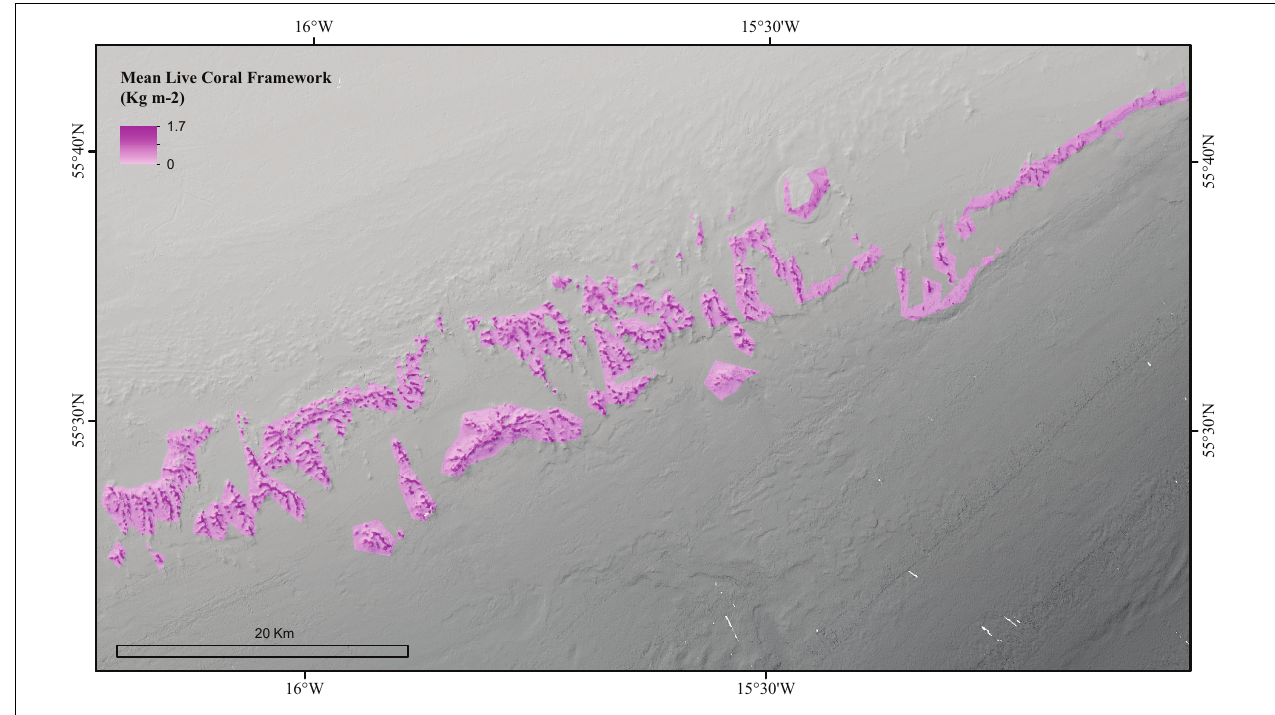
FIGURE 5 | Modeled amount of the mean biomass (Skeletal weight + live tissue weight) of live coral framework in the coral habitat suitability model area of the Logachev Mound Province.